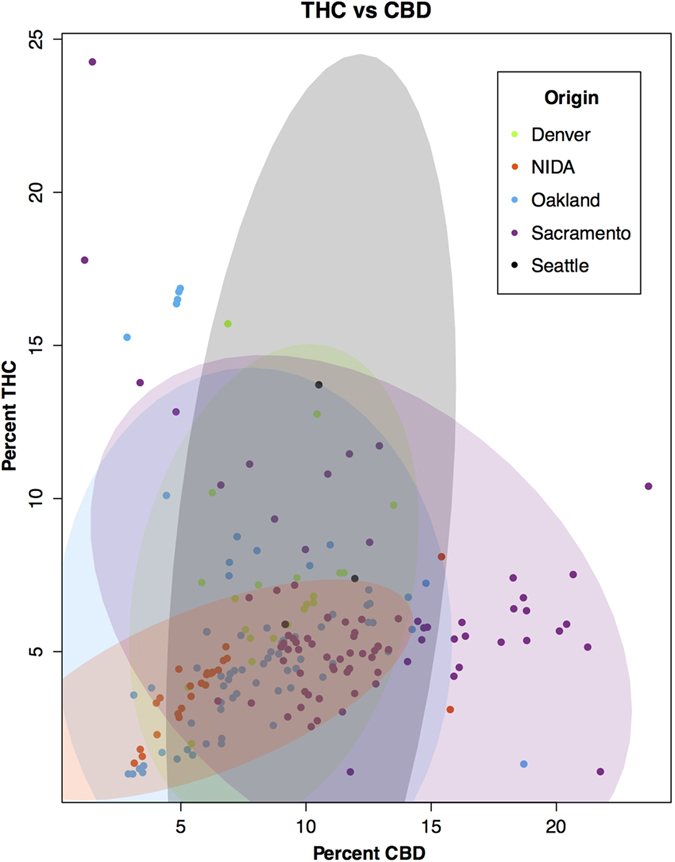
The diversity and variability of Cannabis samples across sites in terms of THC, CBD.The ellipses represent 95% confidence (N = 1152).